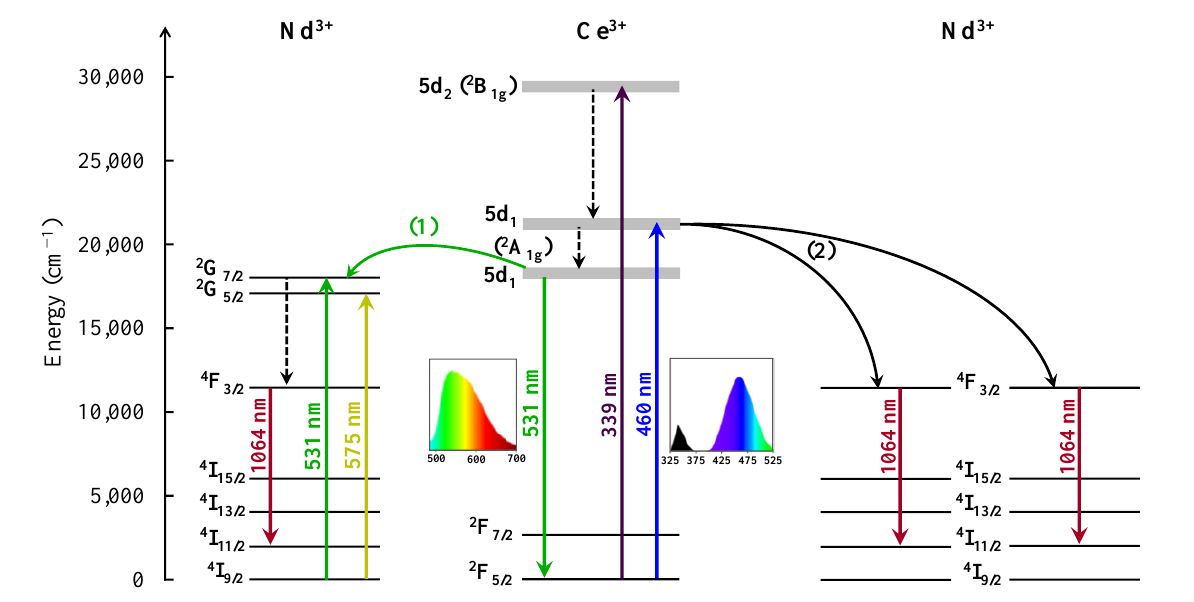
Figure 2. Energy-level diagram illustrating the energy transfer mechanisms between Ce 3+ and Nd 3+ ions in the Ce:Nd:YAG active medium (adapted from [36]). (1) Radiative energy transfer pathway. (2) Quantum cutting down-conversion pathway.